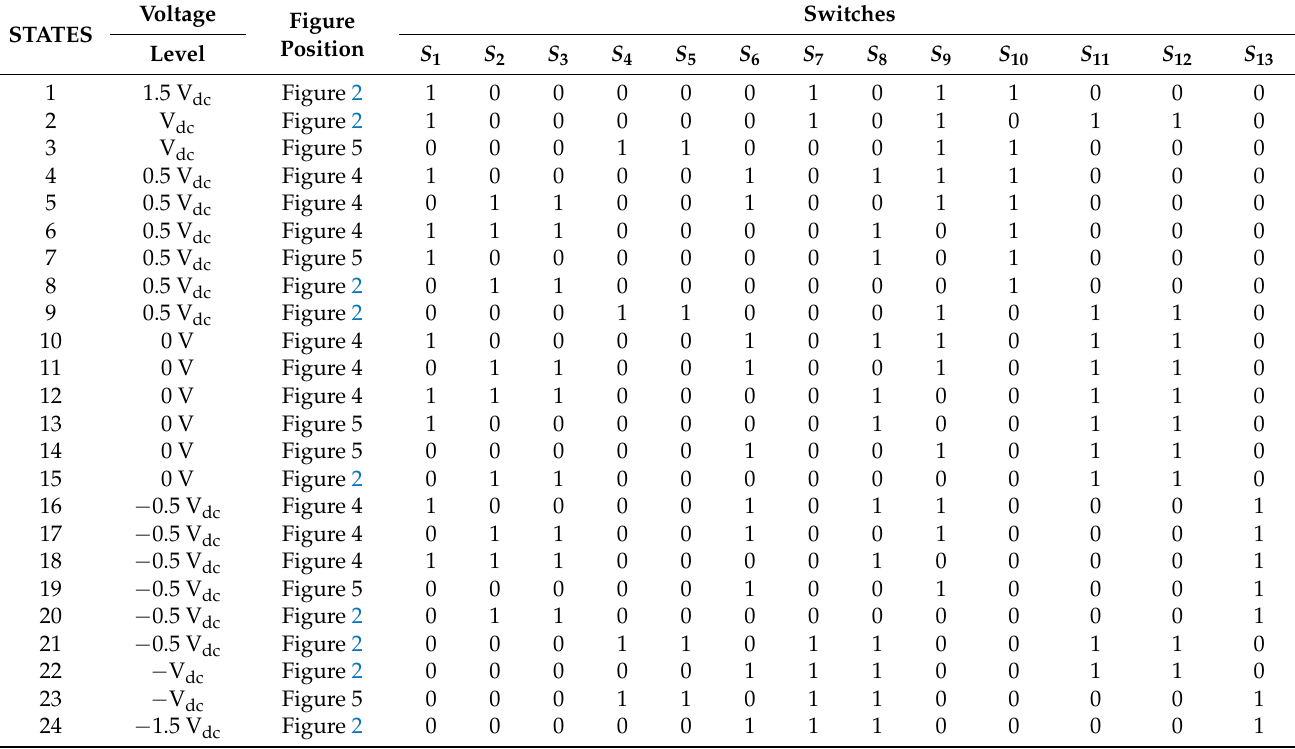
Table 1. All switching states of the proposed three-phase SCMLI.